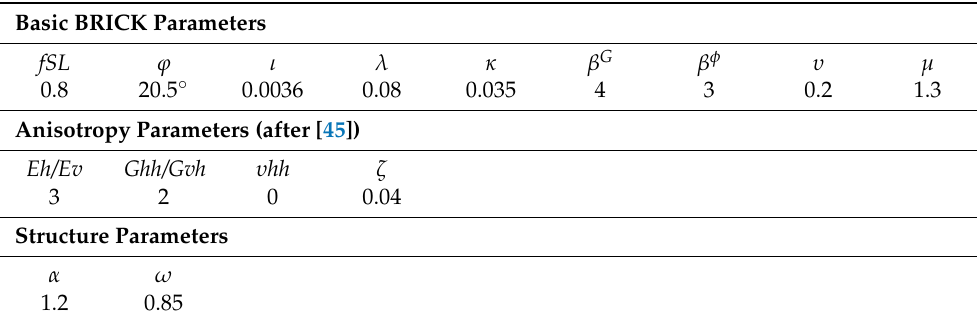
Table 3. Input parameters for SA_BRICK.